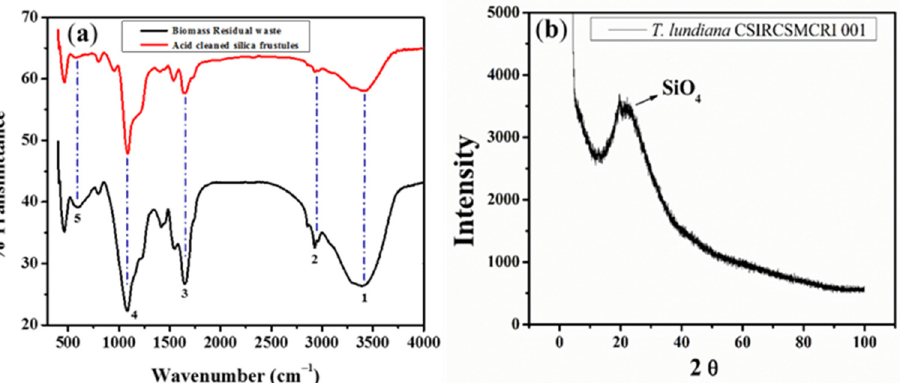
Figure 3. Spectral annotation of the diatom T. lundiana CSIRCSMCRI 001. ( a ) FTIR spectral response of vacuum-dried spent biomass waste (black colure spectra) and acid-treated biomass residues (red line spectra). ( b ) XRD pattern of purified diatomite powder (Keiselgur). line spectra). ( b ) XRD pattern of purified diatomite powder